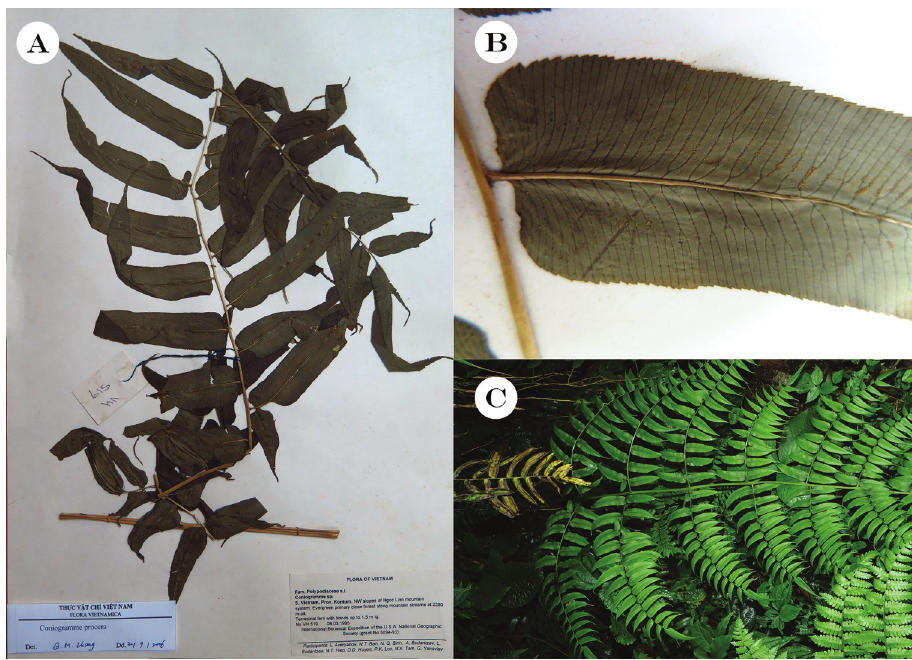
Figure 2. Coniogramme procera Fée. A One of the voucher specimens B Portion of a pinnule, showing a truncate base C Morphology and habitat.